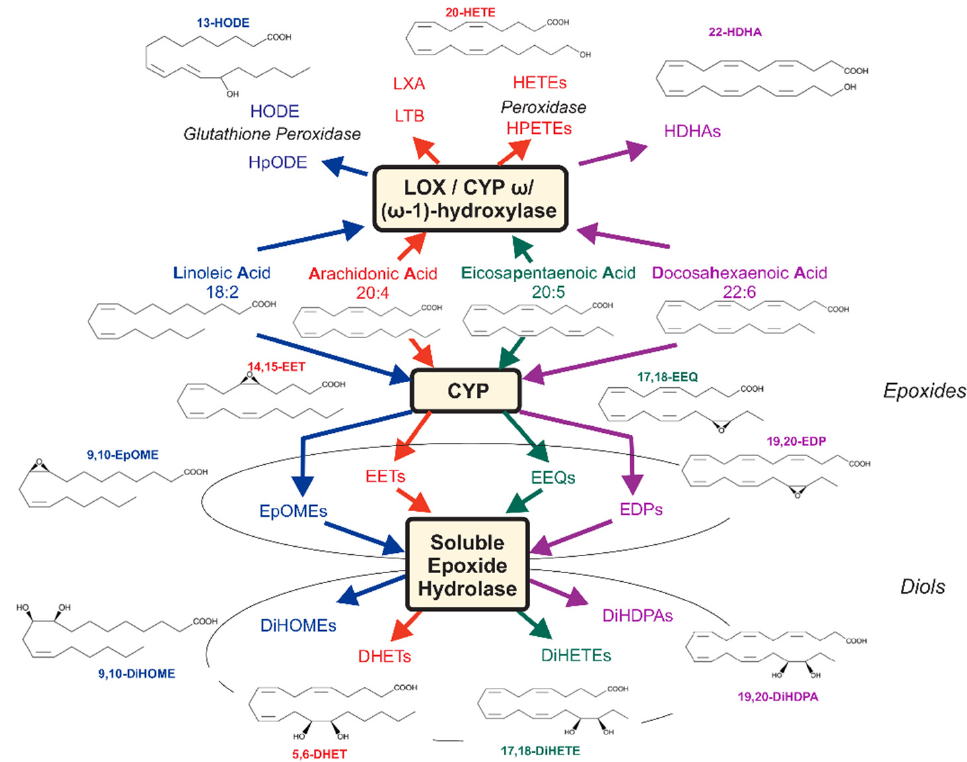
Figure 1. Assessment of cytochrome P450 epoxygenase (CYP) and 12- and 15-lipoxygenase (LOX)/CYP (omega-1)-hydroxylase pathways in response to hemodialysis treatment. Arachidonic (AA), linoleic (LA), eicosapentaenoic (EPA), and docosahexaenoic acids (DHA) are converted to epoxyoctadecenoic acids (EpOMEs, e.g., 9,10-EpOME), epoxyeicosatetraenoic acids (EEQs, e.g., 17,18-EEQ), epoxyeicosatrienoic acid (EETs, e.g., 5,6-EET), and epoxydocosapentaenoic acids (EDPs, e.g., 19,20-EDP) by CYP epoxygenase, respectively. EpOMEs, EETs, EEQs, and EDPs are primarily converted to dihydroxyctadecenoic acids (DiHOMEs), dihydroxyeicosatrienoic acids (DHETs, e.g., 5,6-DHET), dihydroxyeicosatetraenoic acids (DiHETEs, e.g., 17,18-DiHETE), and di- hydroxydocosapentaenoic acids (DiHDPAs, e.g., 19,20-DiHDPA) by the soluble epoxide hydrolase (sEH). LA, EPA, AA, and DHA are converted to hydroperoxylinoleic acids (HpODEs), hydroxyoc- tadecadienoic acids (HODEs), leukotriene B (LTB), lipoxin A (LXA), hydroxydocosahexaenoic acids (HDHAs), hydroperoxyeicosatetraenoic acids (HPETEs), and hydroxyeicosatetraenoic acids (HETEs) by LOX, CYP omega/(omega-1)-hydroxylase, and peroxidase pathways. The metabolites measured in these metabolic pathways follow the changes observed in LA, AA, EPA, and DHA metabolism, respectively. Modified from